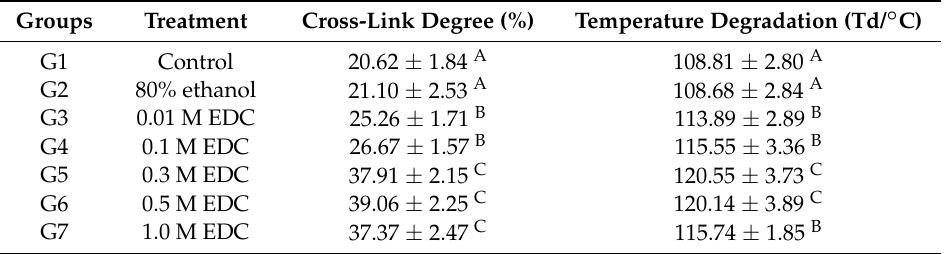
Table 2. Cross-link degree and denaturation temperature ( T d /°C) of demineralized dentin powder with and without EDC treatment (means ± standard deviation).